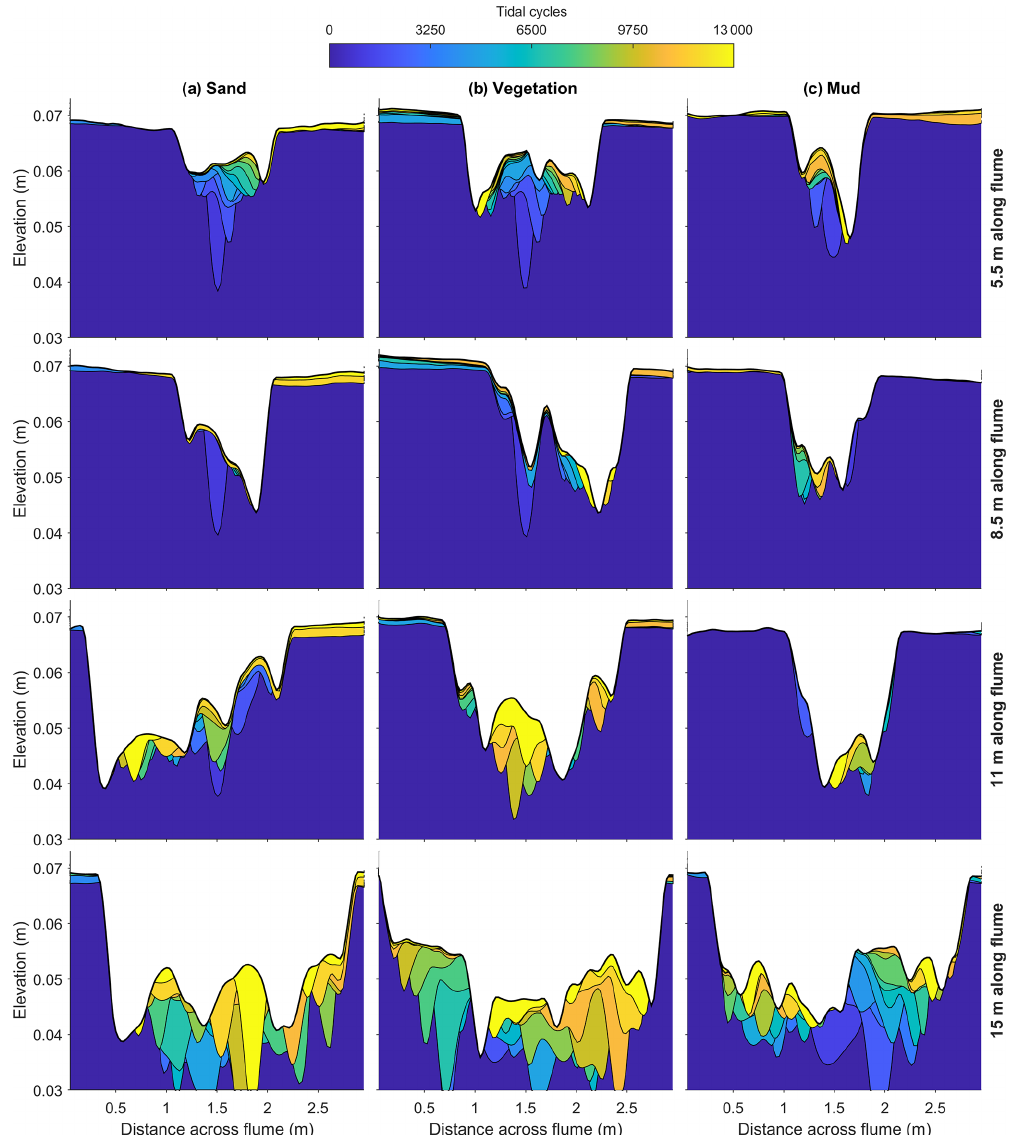
Figure 6. Cross sections with age of deposit, showing the preserved part of the morphodynamics in the experiments with (a) sand only, (b) vegetation and (c) mud for four positions along the flume. Bed level data of every 1000 cycles were used. The vertical exaggeration is a factor of